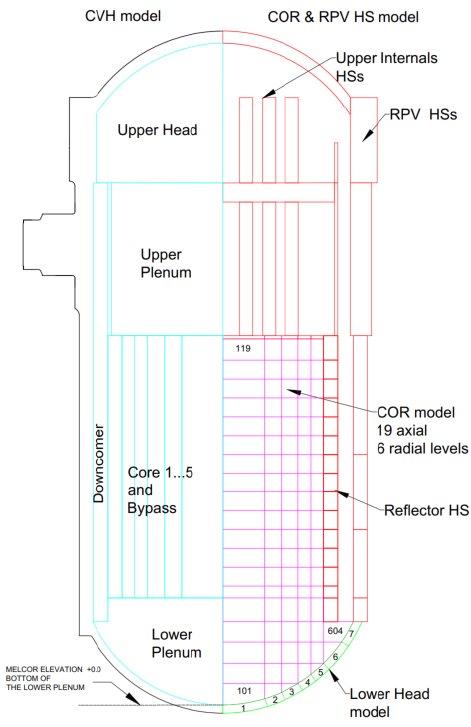
Figure 3. RPV and core nodalization for CVH, COR, and HS package models. Table 1. Comparison of basic design details for PWR and FPT-1.